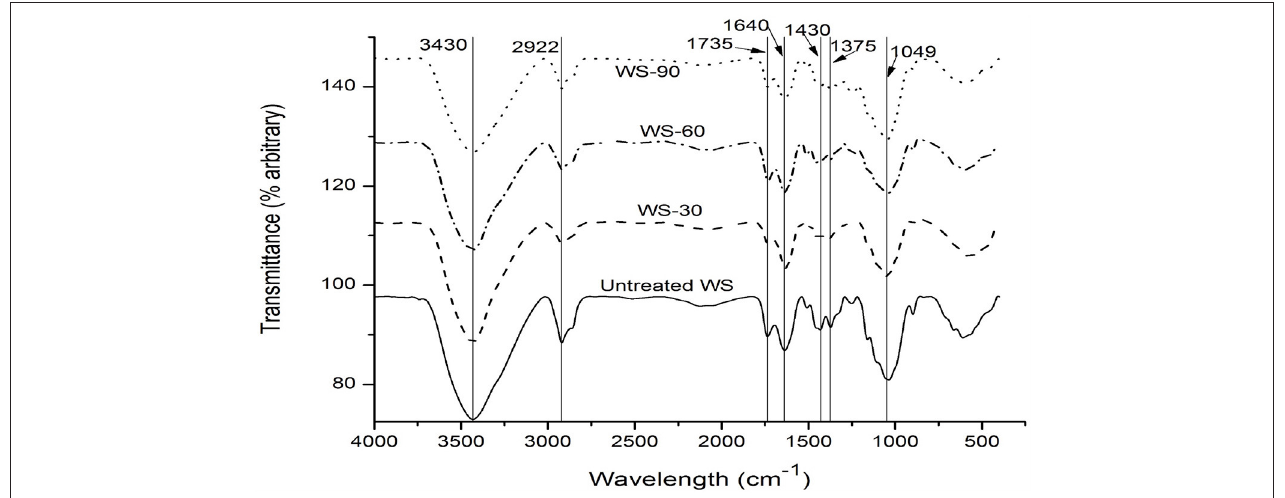
FIGURE 9 | The FT-IR spectra of WS samples.